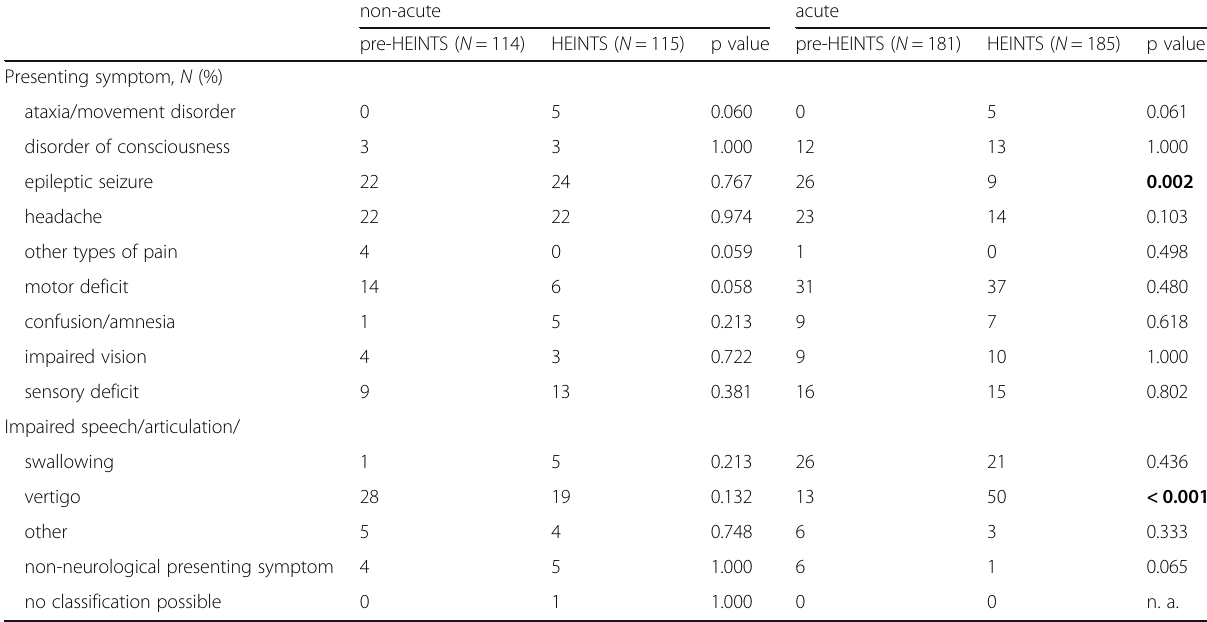
Table 2 Presenting symptoms of acute and non-acute patients in pre-HEINTS and HEINTS groups non-acute acute